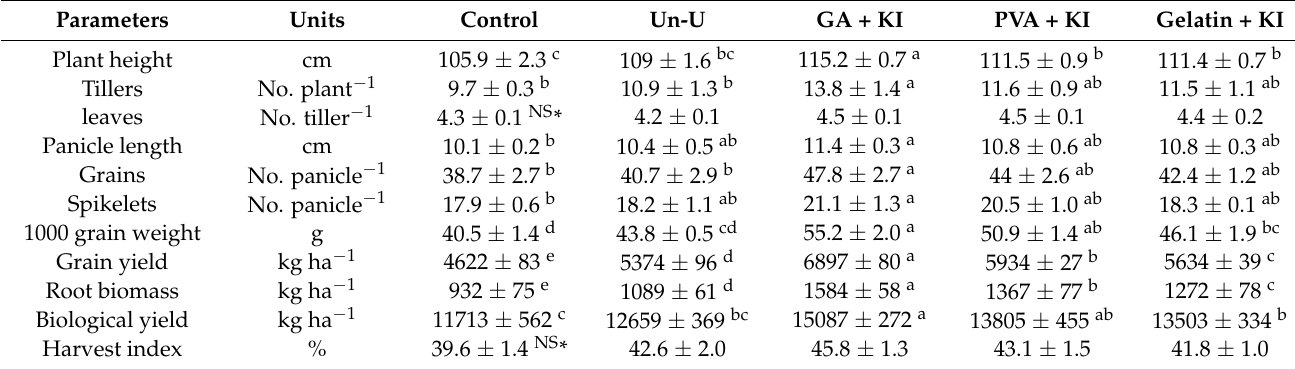
Table 1. Mean (n = 3) physiological and yield attributes of wheat crop as influenced by the control (unfertilized), uncoated urea (Un-U), and urea coated with Gum Arabica and potassium iodide (GA + KI), polyvinyl alcohol and potassium iodide (PVA + KI), and gelation and potassium iodide (Gelatin Gelatin + KI). Different small letters in a row illustrated significant differences among treatments at a 5% probability level after the Tukey-HSD